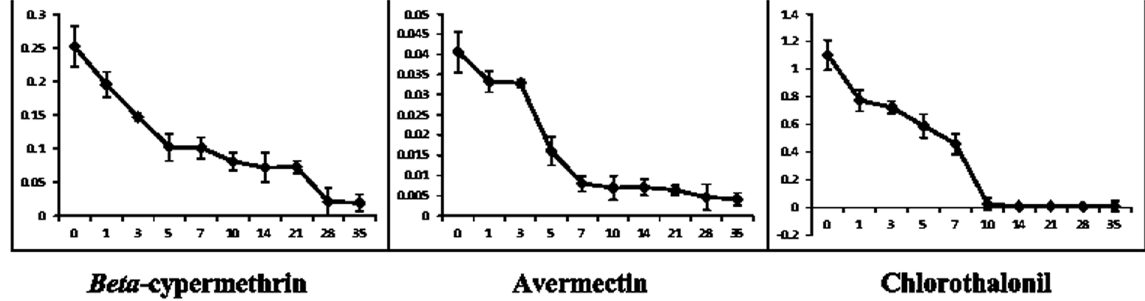
Figure 1. Dissipation patterns of beta -cypermethrin, avermectin and chlorothalonil in soil.